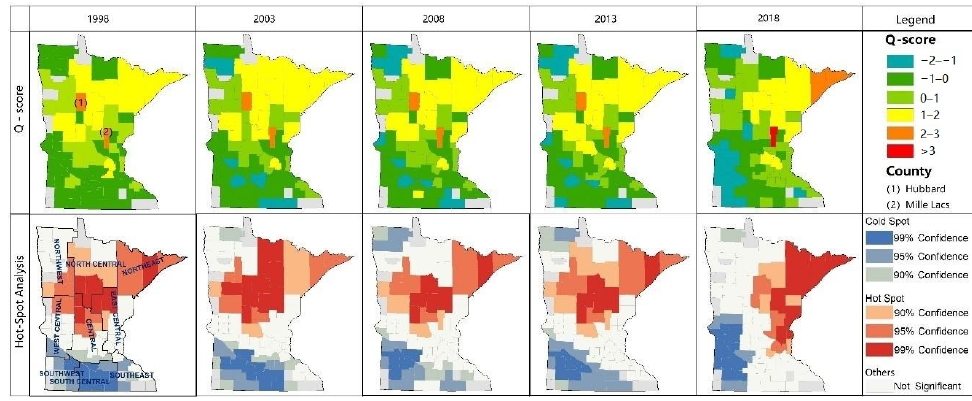
Figure 11. Q-score distribution and spatial clustering.